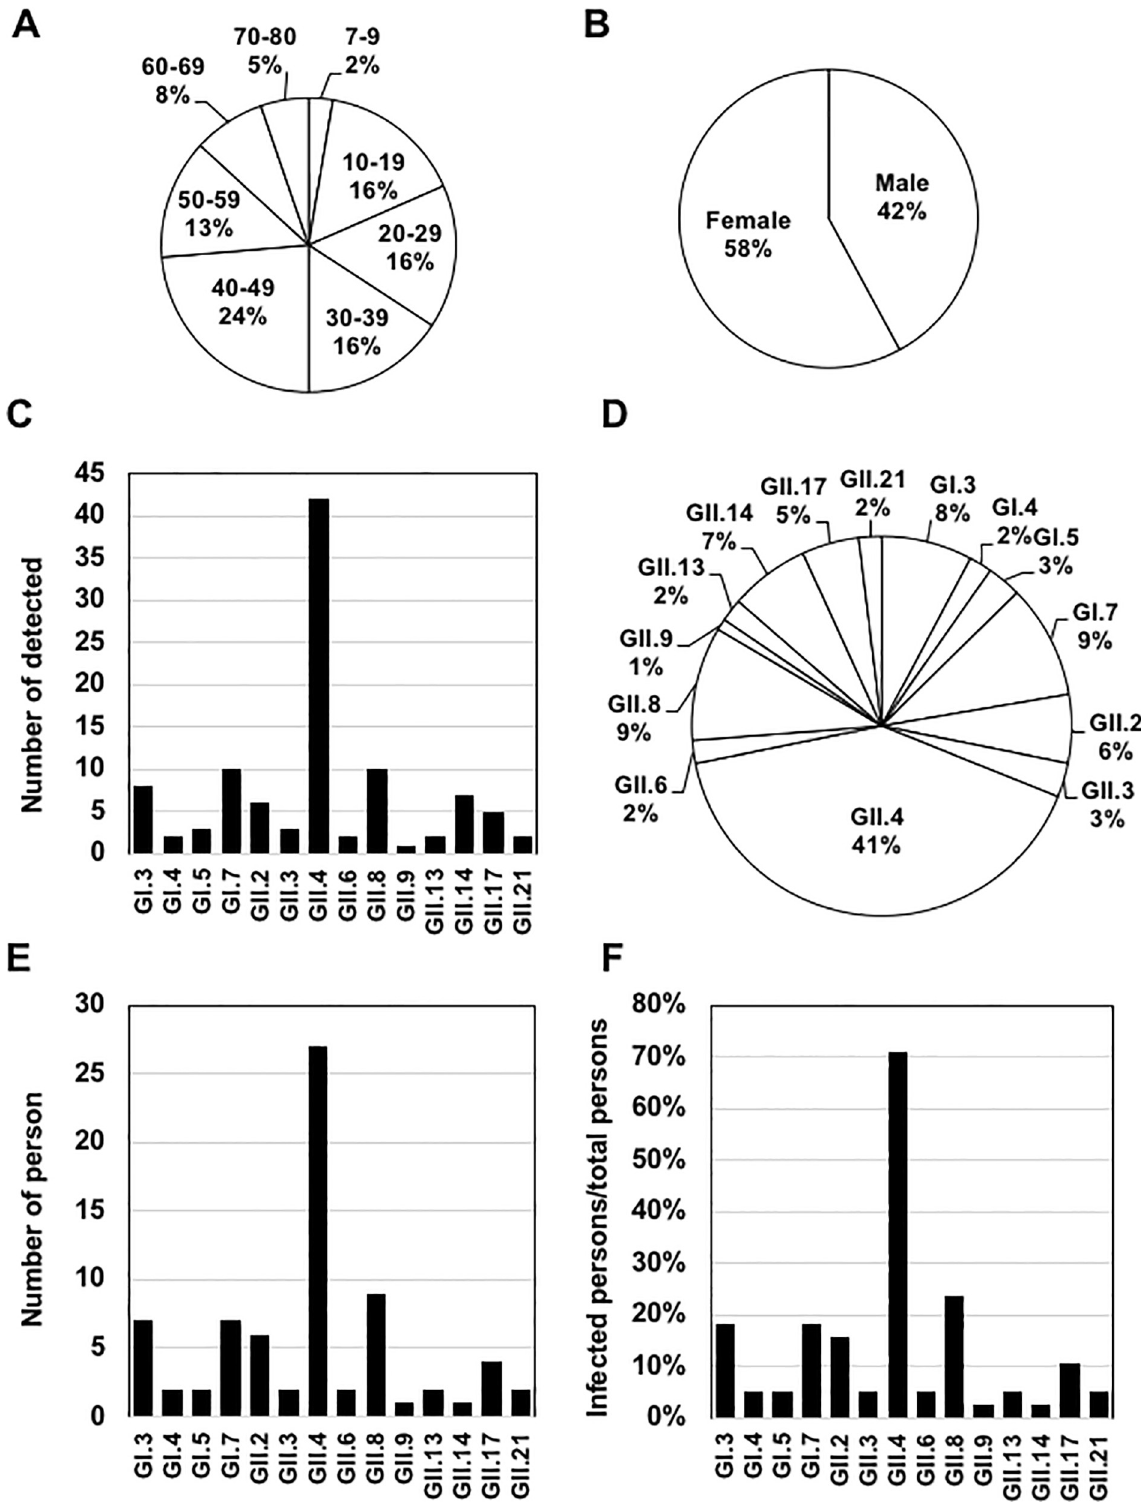
Fig 2. NV infections in the 1-year survey. (A) Age distribution of the participants. (B) Gender distribution of the participants. (C) The detection frequency of each genotype. The total number of samples with each genotype was counted. (D) The genotype distribution in the 1-year survey. (E) The number of participants infected with each genotype. (F) The ratio of participants infected with each genotype among the total participants. https://doi.org/10.1371/journal.pone.0236502.g002 PLOS ONE | https://doi.org/10.1371/journal.pone.0236502 July 23,